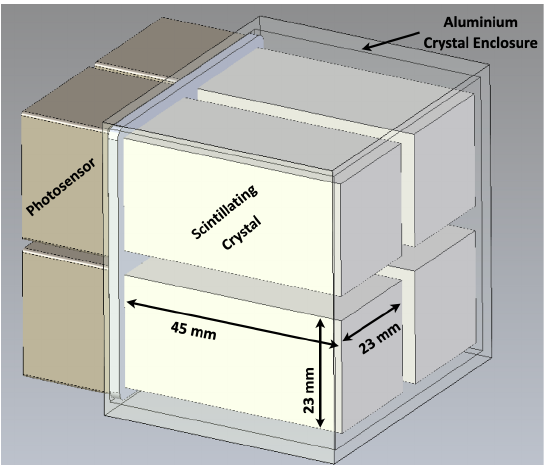
Figure 4. The core of the reference detector consists of a 4-fold scintillating crystal array read out by as many photosensors and encapsulated in an aluminum enclosure (transparent body visible in the figure).